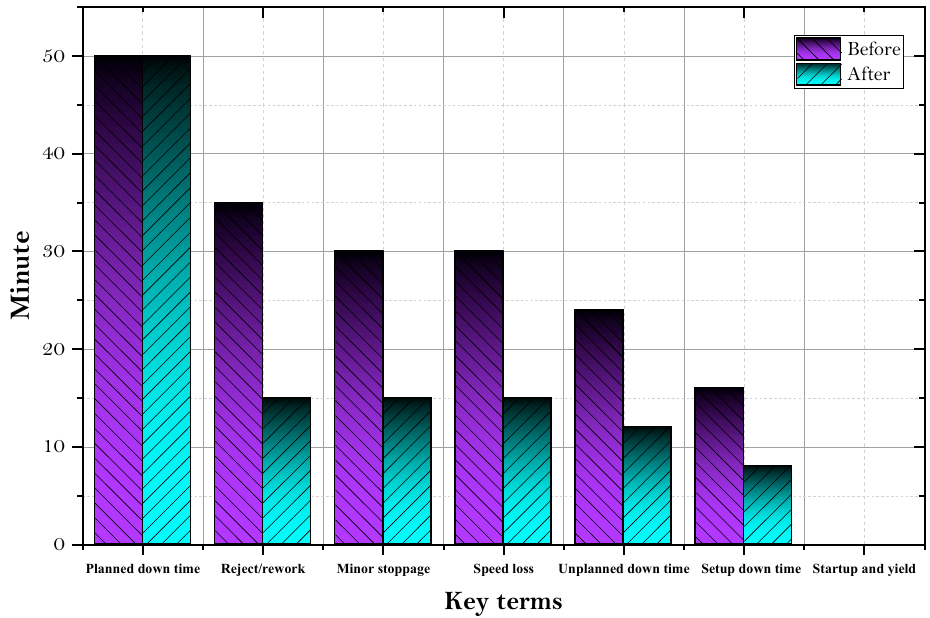
Figure 13. Comparison of seven big losses.